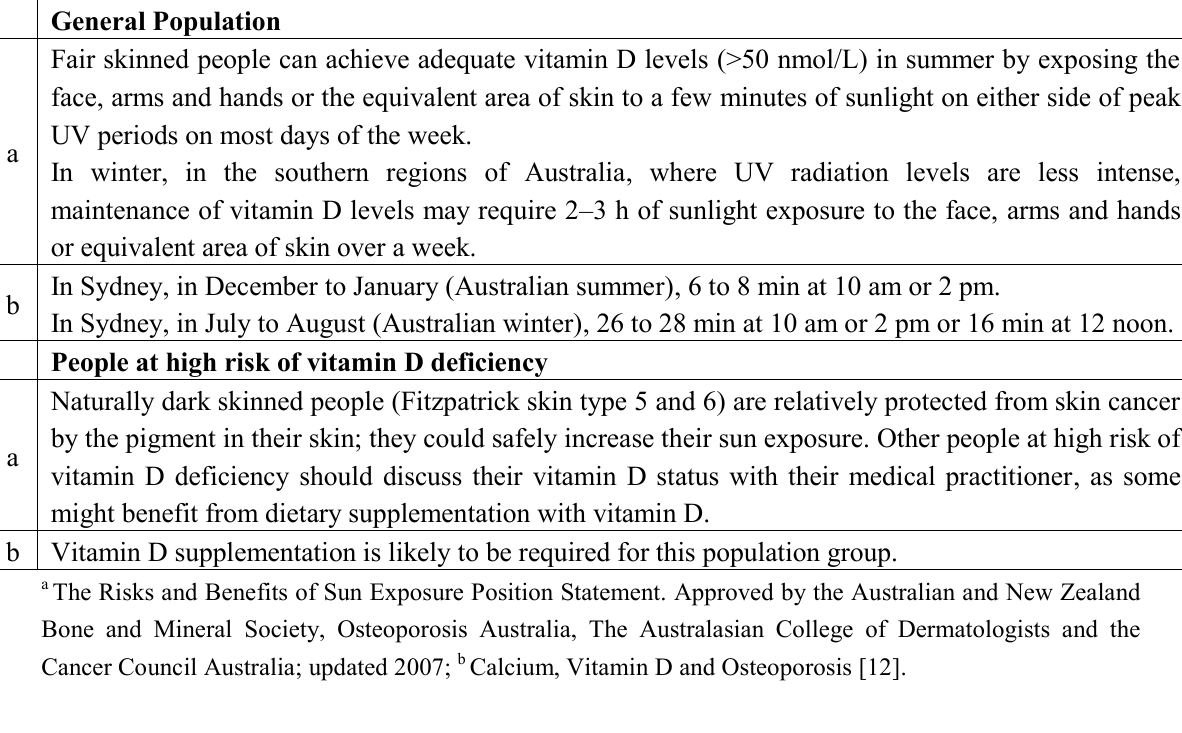
Table 2. Summary of key Australian guidelines for sun exposure for vitamin D sufficiency for the general population (moderate fair skin) and people at high risk of vitamin D